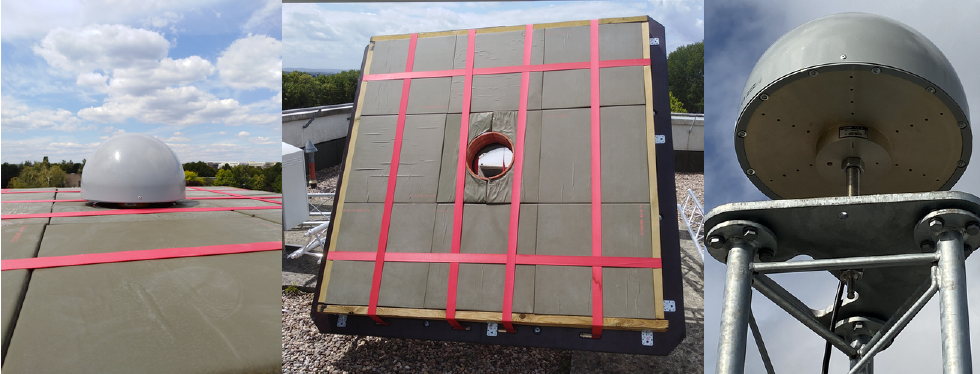
Figure 4. The photograph of KBG1 station’s Trimble (TRM159800.00) geodetic Choke Ring GNSS antenna integrated with SCIS radome ( left ) and the Eccosorb AN-W-79 (microwave absorber) material that surrounds station KBG1 ( middle ) and KBG2 antenna, Trimble (TRM159800.00) geodetic Choke Ring GNSS antenna integrated with an SCIS radome ( right